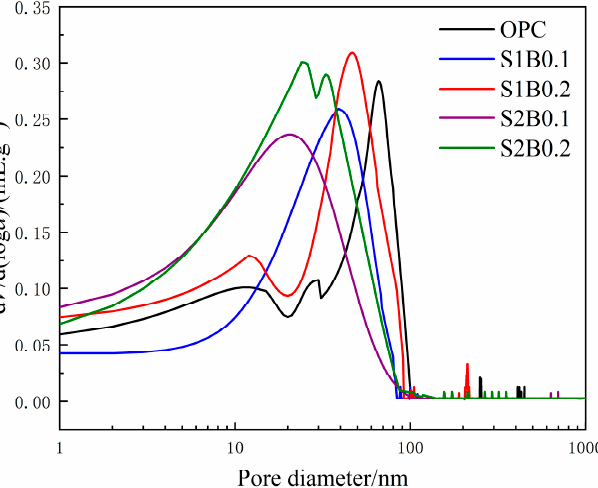
Figure 7. Pore distribution of fiber concrete under an acid rain environment.